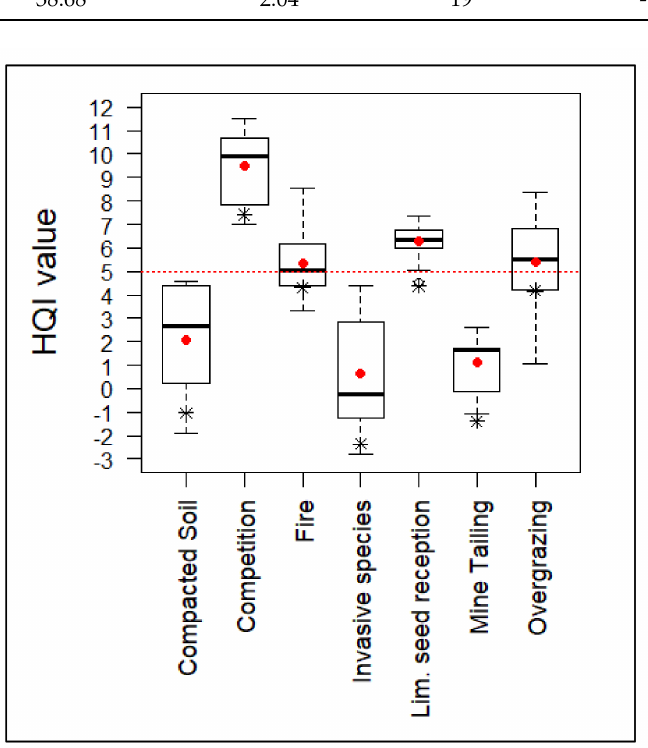
Figure 4. HQI values after the implementation of habitat improvement actions. Red dotted line represents the value from which the habitat quality index is considered favorable. Average value of the groups is represented by a red dot. Initial average value is represented by an